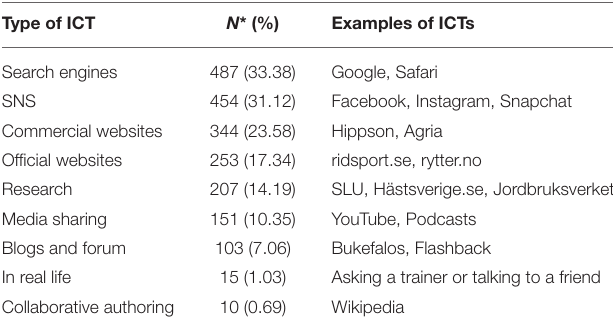
TABLE 1 | Number (and percentage of) users using different types of information and communications technologies (ICTs) to obtain information on horses and